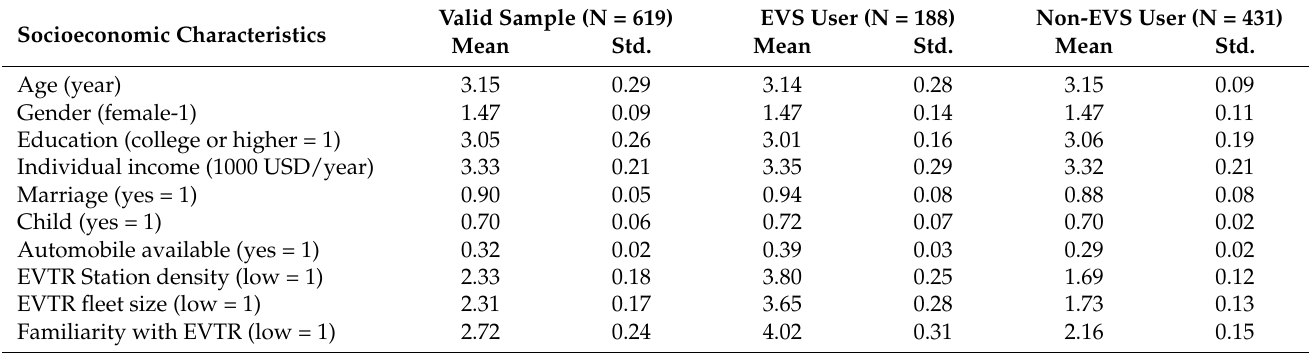
Table 3. Statistics of socioeconomic characteristics of